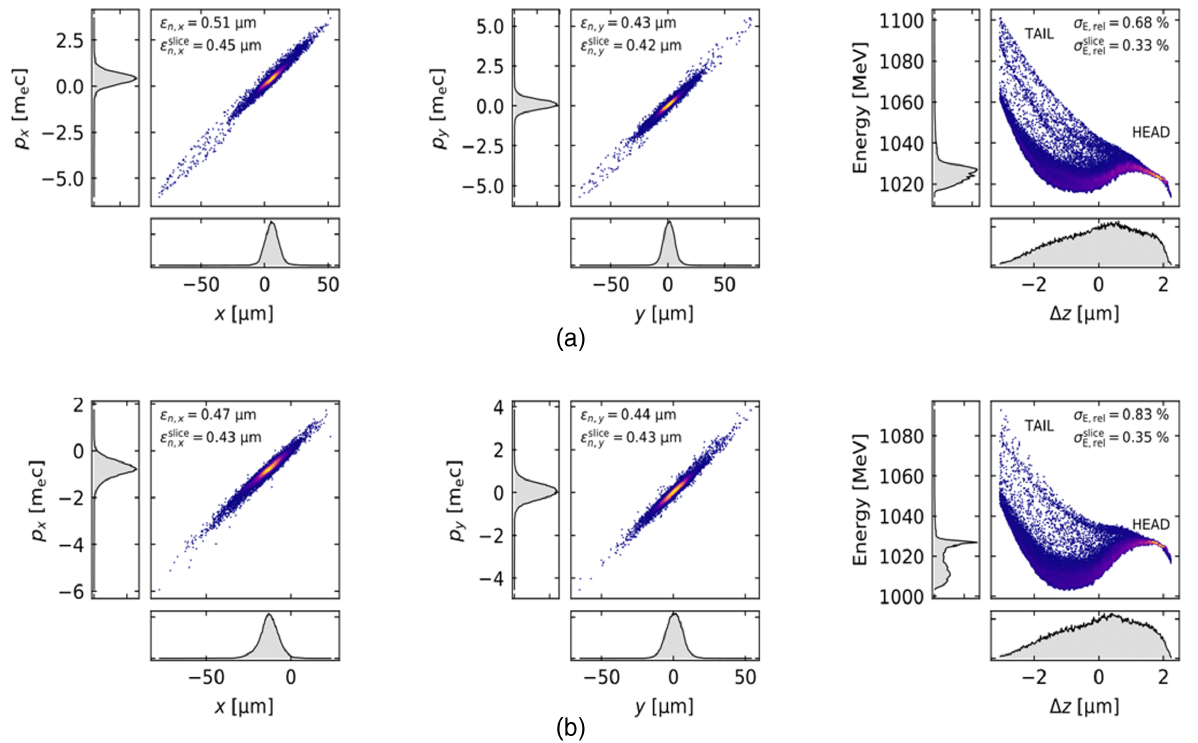
FIG. 9. Phase spaces at the exit of the plasma cell for (a) simulated beam matched to the plasma entrance (reference case from Sec. V) (b) perturbed beam, according to mismatch case 1 of Fig. 7. The beam is tracked through the plasma cell using FBPIC